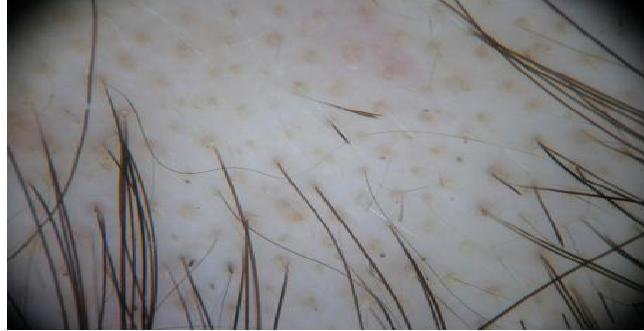
Figure (3) : Alopecia areata